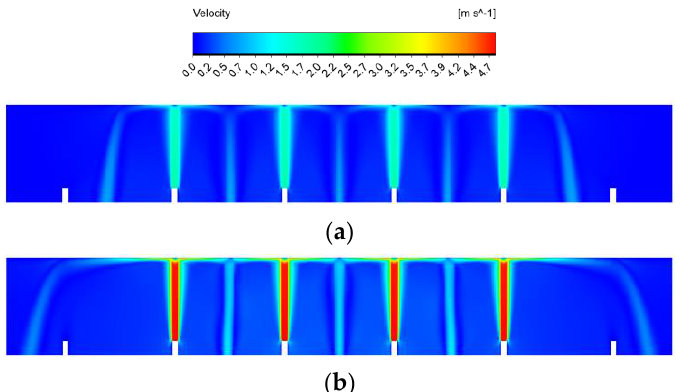
Figure 4. Comparison of velocity contours between two mass flow rates in the YZ-plane at c = 2%, I = 1000 W/m 2 , h sl = 107.1 kJ/kg, N = 8, and H = 30 mm. ( a ) ṁ = 0.045 kg/s and ( b ) ṁ = 0.12 kg/s.